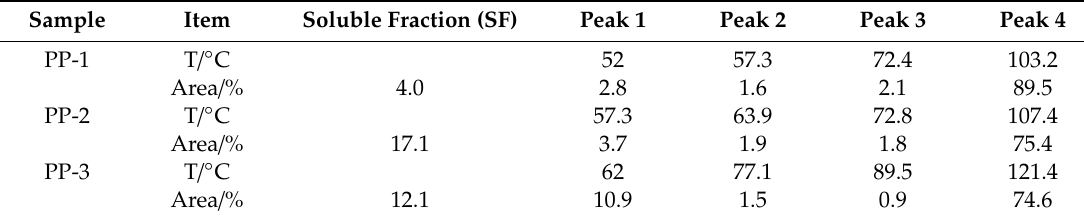
Table 7. TREF analysis